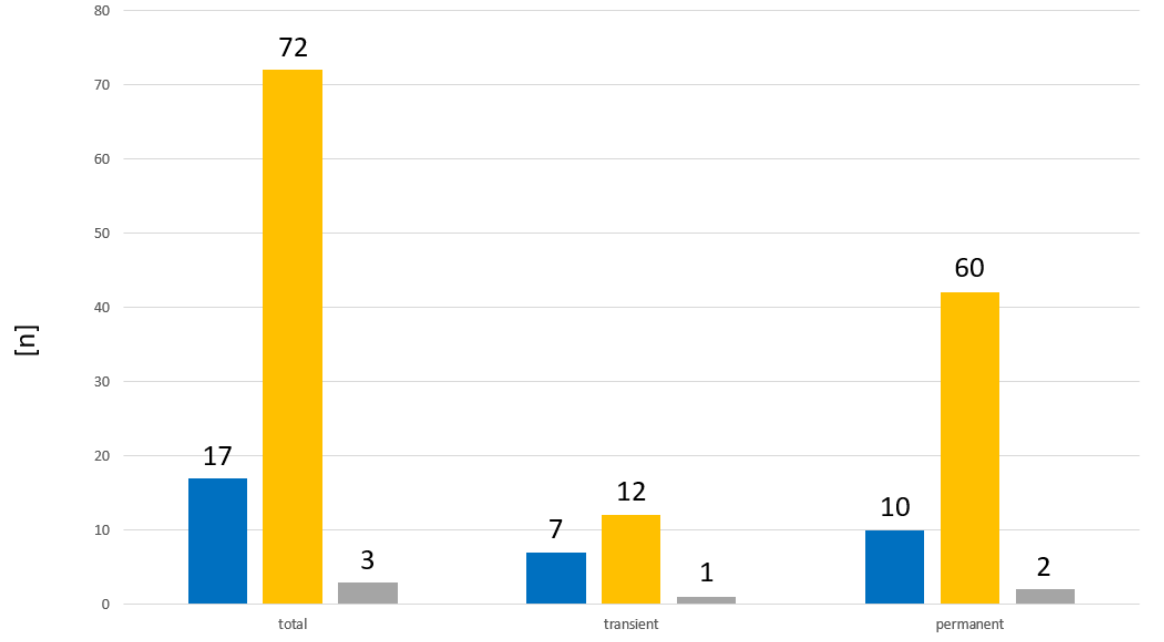
Figure 4. Distribution of family history in patients with CH. ■ Positive family history. ■ Negative family history. ■ Family history not recorded.